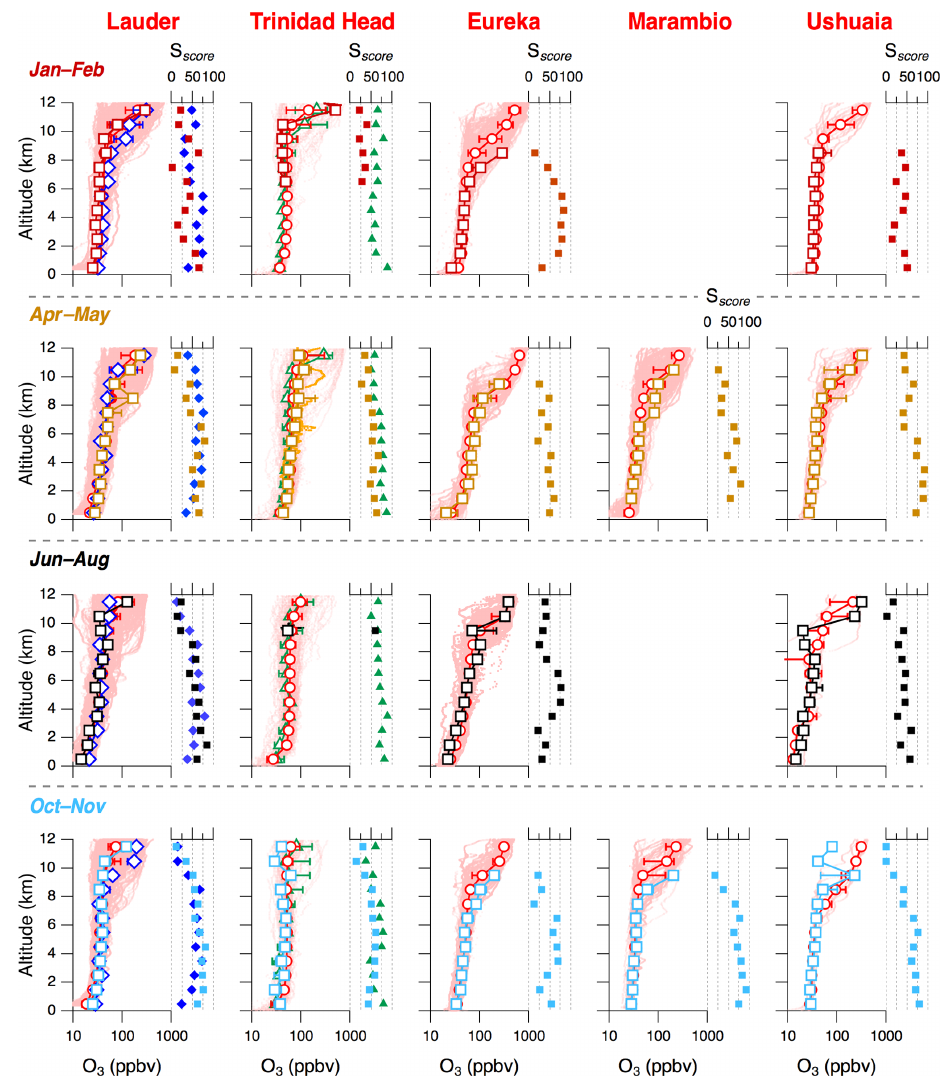
Figure 6. Same as in Fig. 5 but for ozonesonde launching sites located in middle and high latitudes (Lauder in New Zealand, Trinidad Head in the USA, Eureka in Canada, Ushuaia in Argentina, and Marambio in Antarctica). O 3 data obtained from the IAGOS program (green triangles) during descents into San Francisco Bay Area airports were also added to the Trinidad Head site for